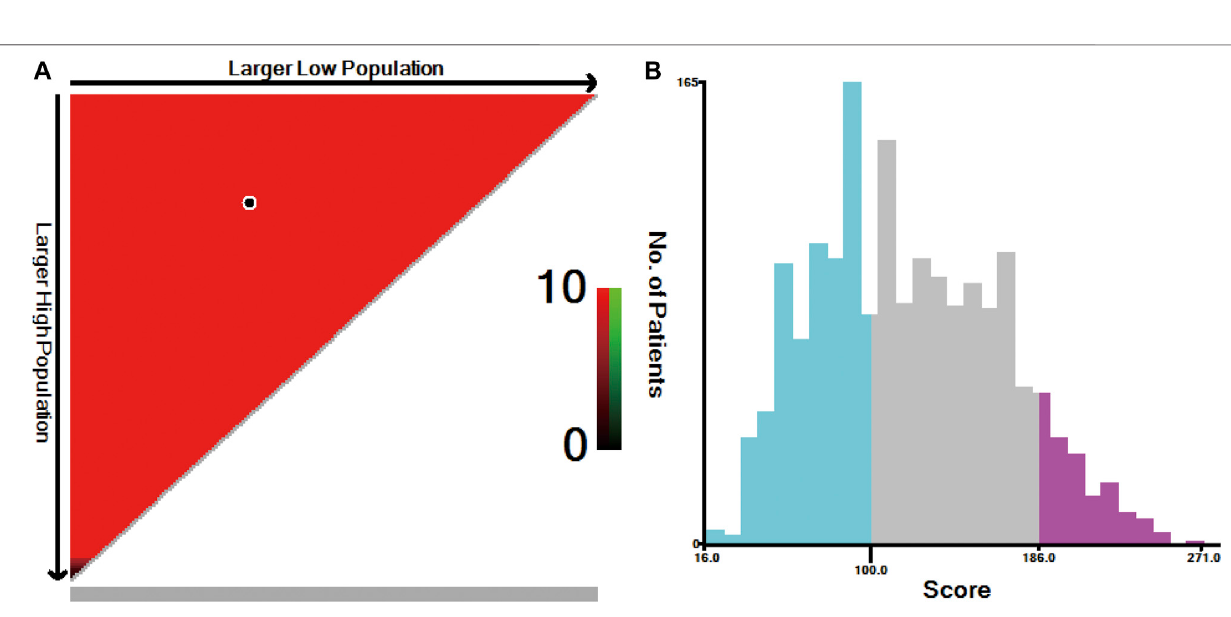
Frontiers in Pharmacology |